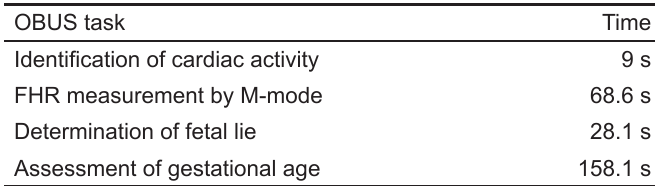
Table 3. Average time to completion of critical OBUS tasks.